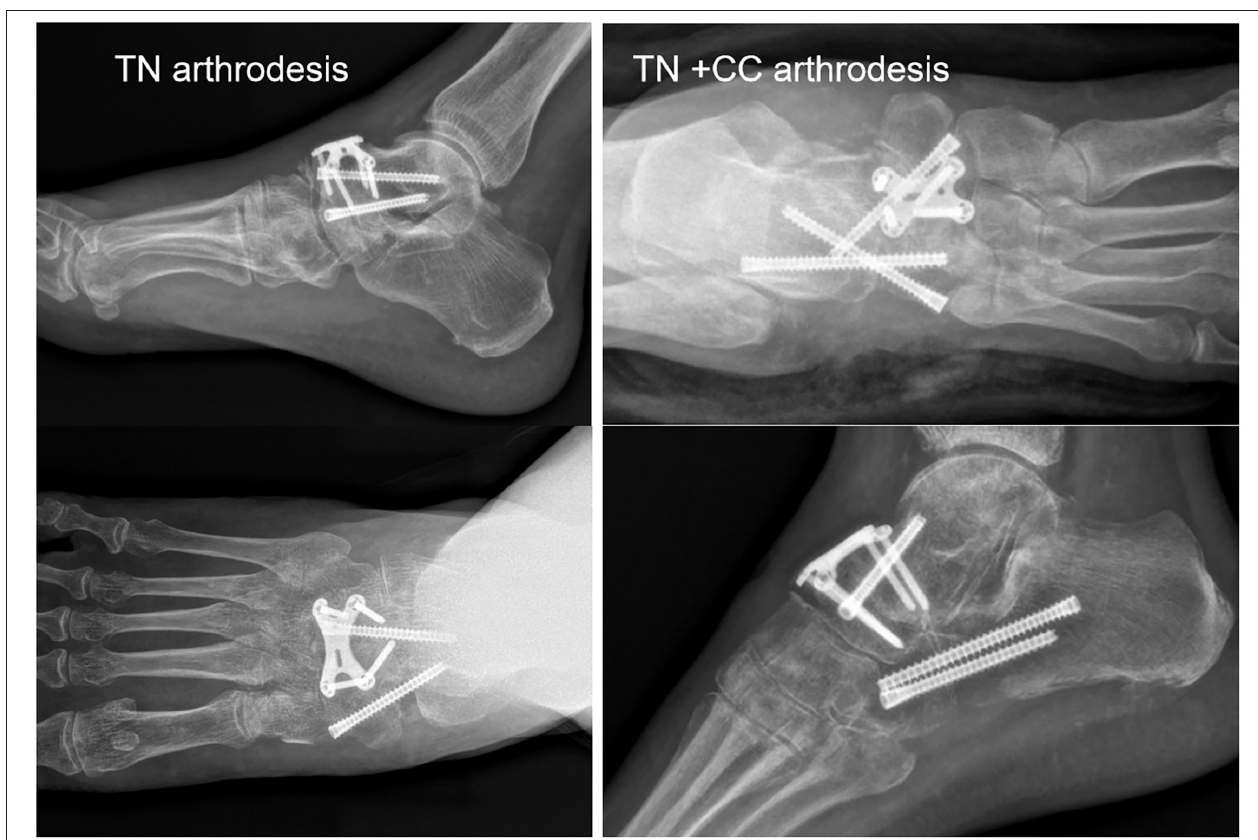
FIGURE 5 | (Left) Anteroposterior (AP) and lat view of TN arthrodesis case. (Right) AP and lat view of TN + CC arthrodesis